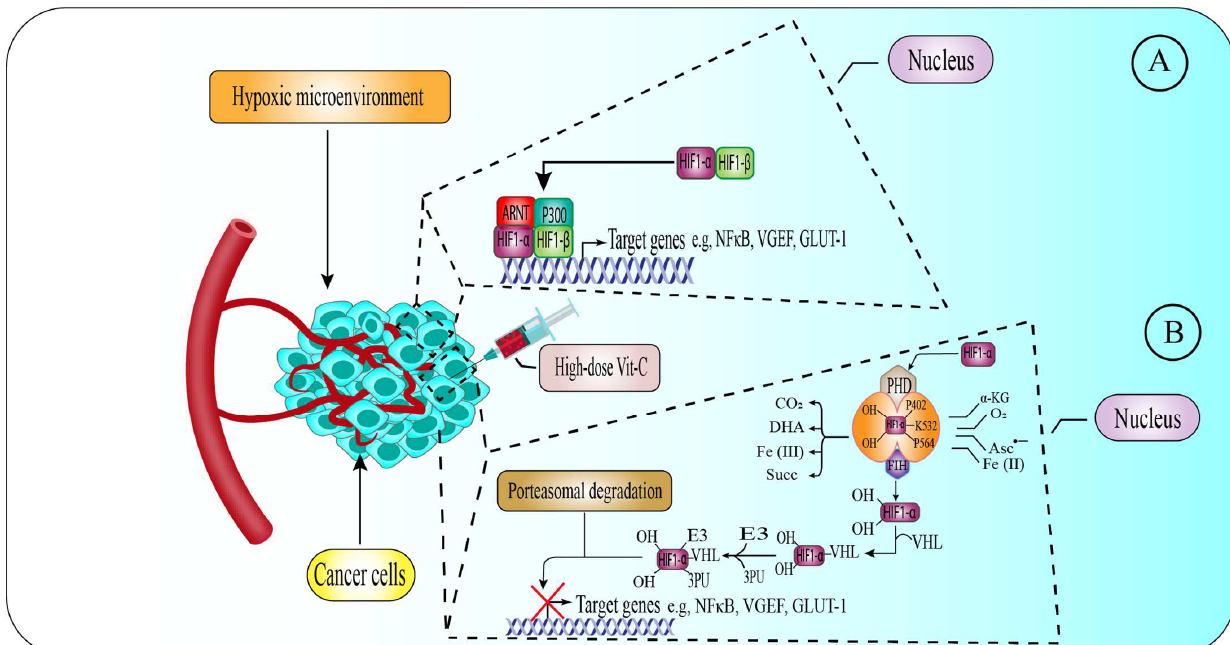
Figure 3. High-dose Vit-C targeting HIF1-α function. (A) In the tumor hypoxic microenvironment, hydroxylation is inhibited, and HIF-1α dimerizes with constitutively expressed HIF-1β, creating an active transcription factor HIF-1complex, which binds with p300 (a co-activator protein) and ARNT, together transcribing genes promoting angiogenesis, glycolytic metabolism, and survival. (B) During high-dose Vit-C administration, HIF hydroxylases, asparagine hydroxylase HIF, and PHDs utilizing ascorbate as a critical cofactor for their optimal activity, these proteins belong to the large family of the α-ketoglutarate (α-KG)-dependent dioxygenase (αKGDD). When the ascorbate availability is high, with sufficient O 2 and Fe(II), HIF inhibits the function of HIF1-α.; consequently, HIF1-α is hydroxylated at proline residues by PHDs, followed by the binding of VHL (tumor suppressor protein), which attracts an E3-ubiquitin ligase enzyme that marks HIF1-α for degradation by proteasome and results in reduction of HIF1-α subunits inside the cancer cell. FIH then mediates the hydroxylation of an asparagine residue, N806, on HIF1-α. This hydroxylation stops p300 from combining with the HIF complex; this inhibits the HIF-1 transcription activity, resulting in downregulation of multiple downstream genes important in cancer development and growth [125–131]. HIF, hypoxia-inducible factor; FIH, factor-inhibiting HIF; ARNT, Aryl Hydrocarbon Receptor Nuclear Translocator; PHDs, proline hydroxylase domain proteins; VHL, von Hippel-Lindau; Succ, succinate.